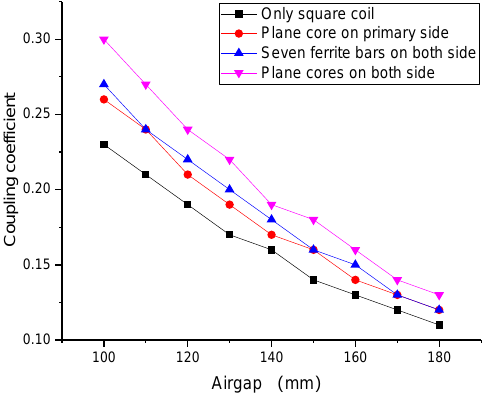
Figure 20. The effects of the ferrite cores on the coupling coefficient. Figure 20. The e ff ects of the ferrite cores on the coupling coe ffi